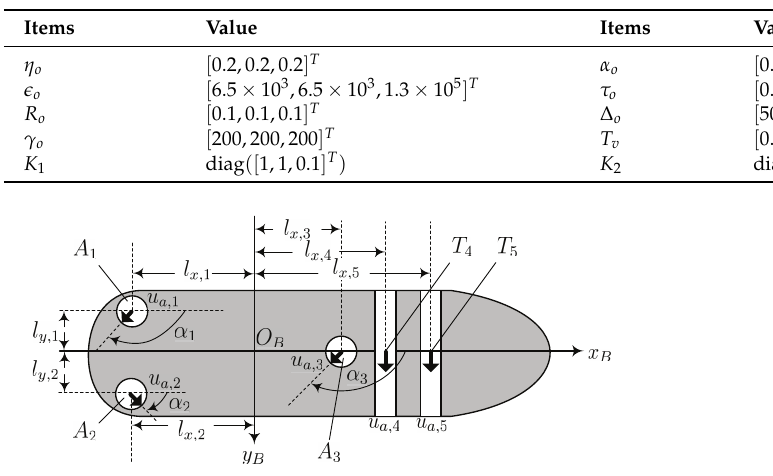
Table 2. Control parameters.